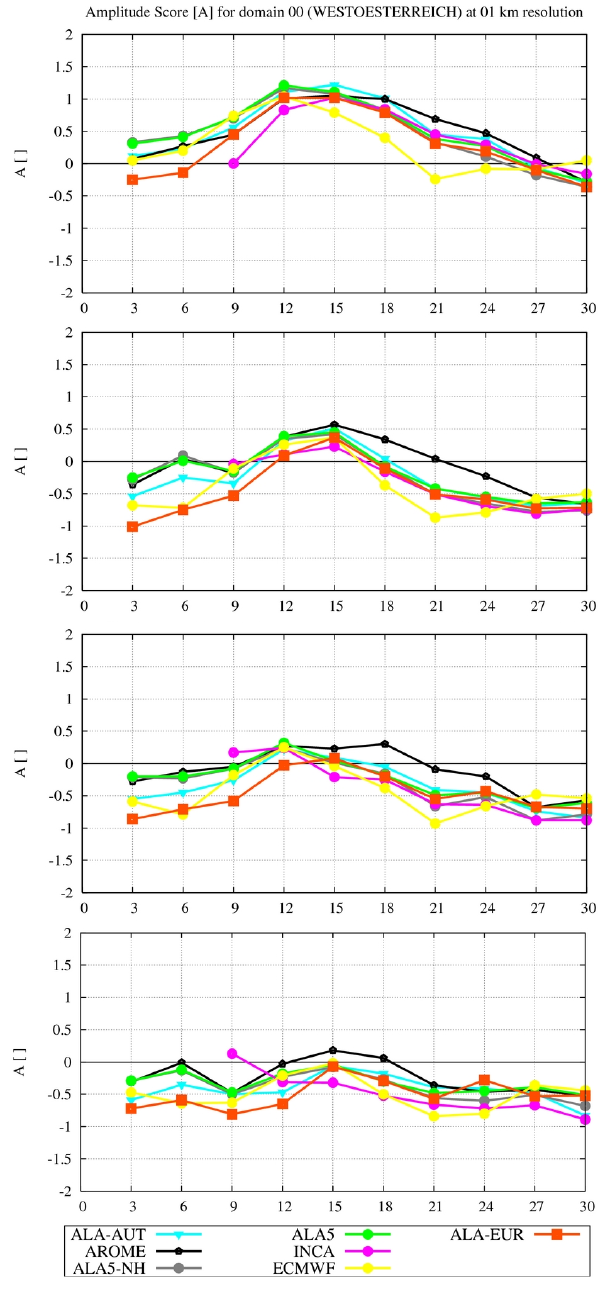
Figure 3. Mean values for SAL amplitude component A as a func- tion of lead time for various models for di ff erent domain average thresholds: (from top to bottom) all events with an observed do- main average greater than 0mm, 0.5mm, 1.0mm, 2.5mm